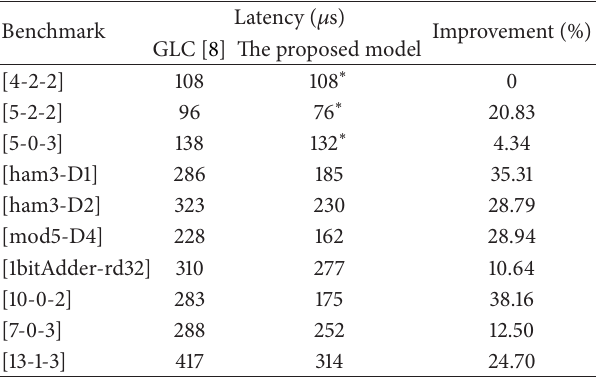
∗ Optimal solution.